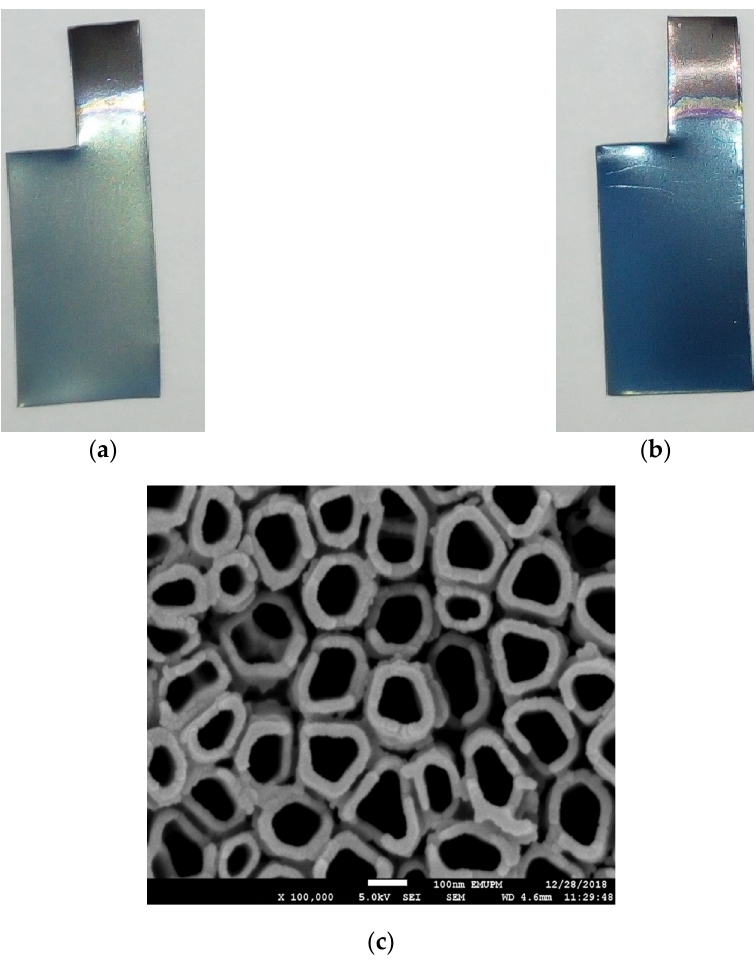
Figure 7. ( a ) Color of TNTs and ( b ) R-TNTs ( c ) FESEM image of R-TNTs.